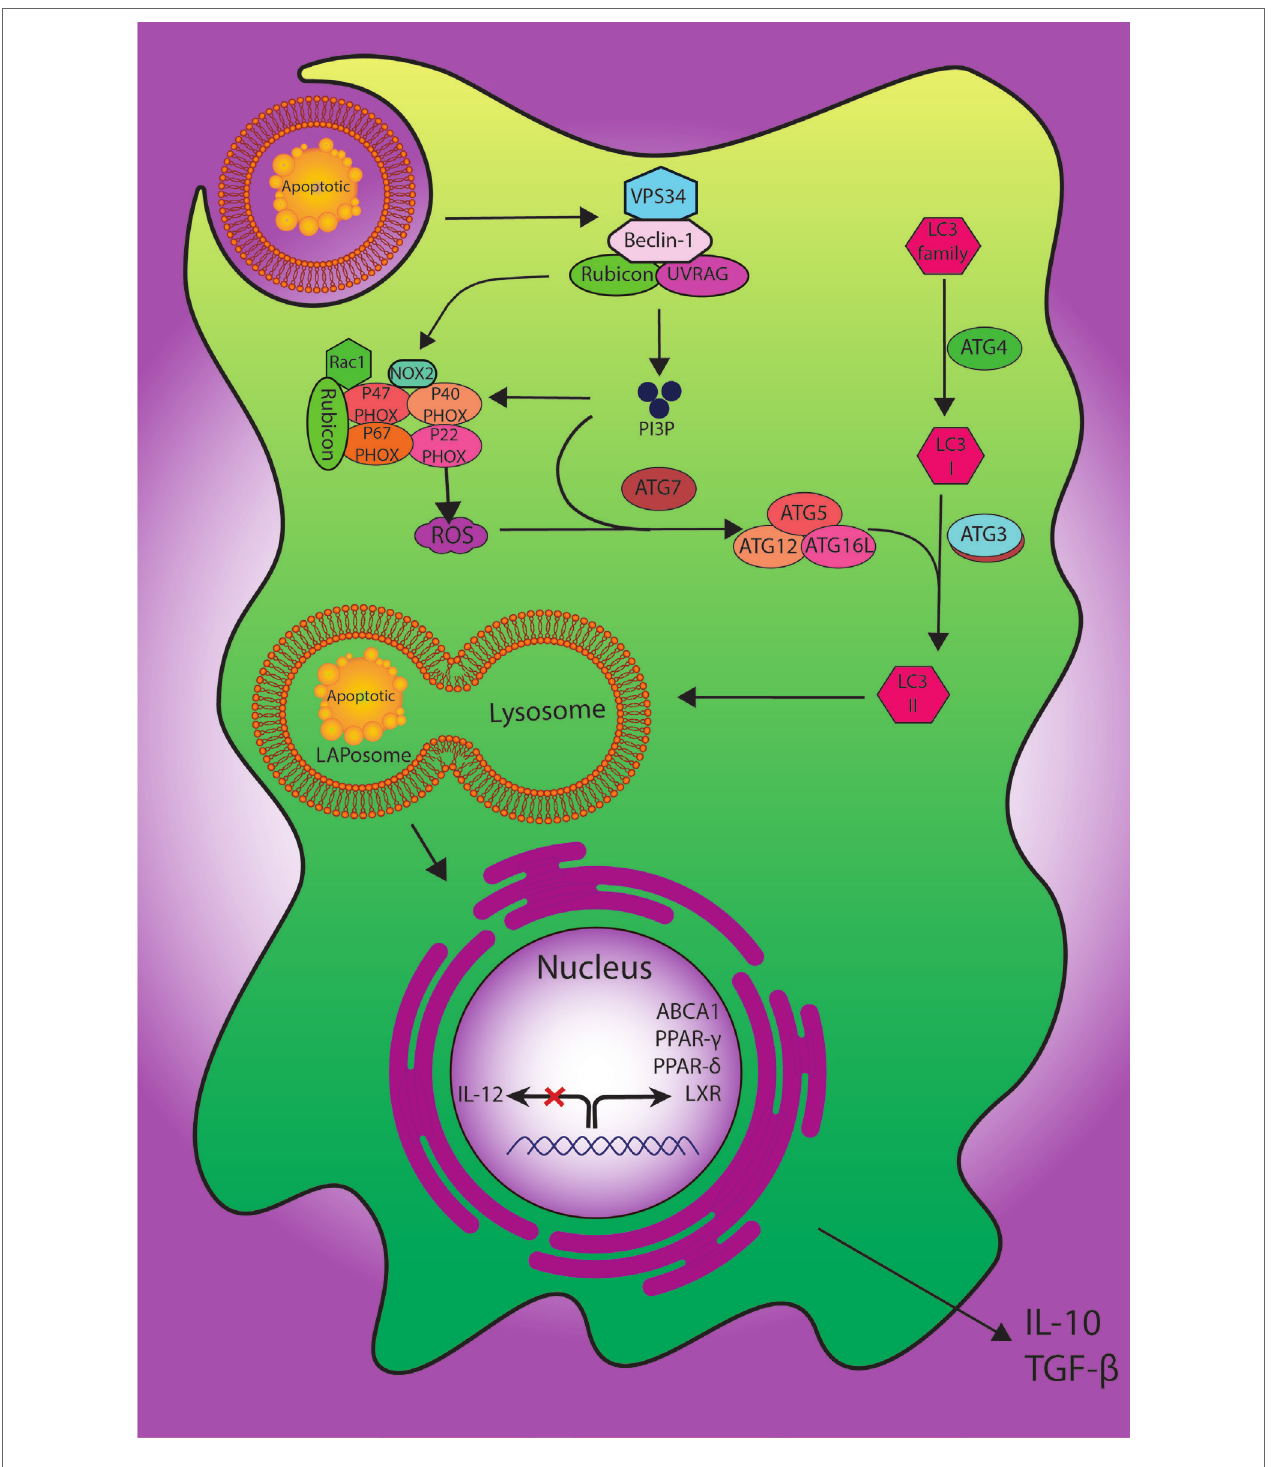
FigURe 2 | The digestion process of engulfed dead cells. During the engulfment of apoptotic cells, LC3-associated phagocytosis (LAP) pathway accompanied by its components and ULK1/2 complex as a canonical autophagy pathway have specific roles. The class III PI3K collection involving VPS34, Beclin-1, UVRAG, and Rubicon are also important to the localization of PI3P at the LAPosome and canonical autophagy. PI3P has two functions: the employment of the downstream autophagic/LAP machinery including ATG5, ATG7, ATG12, and ATG16L, and fixation of the NOX2 set with recruitment of Rubicon. Also, merging the lysosome and LAPosome maturation is in need of LC3-II. The cholesterol sensors such as liver X receptor, ABCA1, PPAR δ , PPAR γ , and PGC-1 β are similarly required for anti-inflammatory impact of efferocytosis, which can result in producing anti-inflammatory modulator such as IL-10 and TGF- β